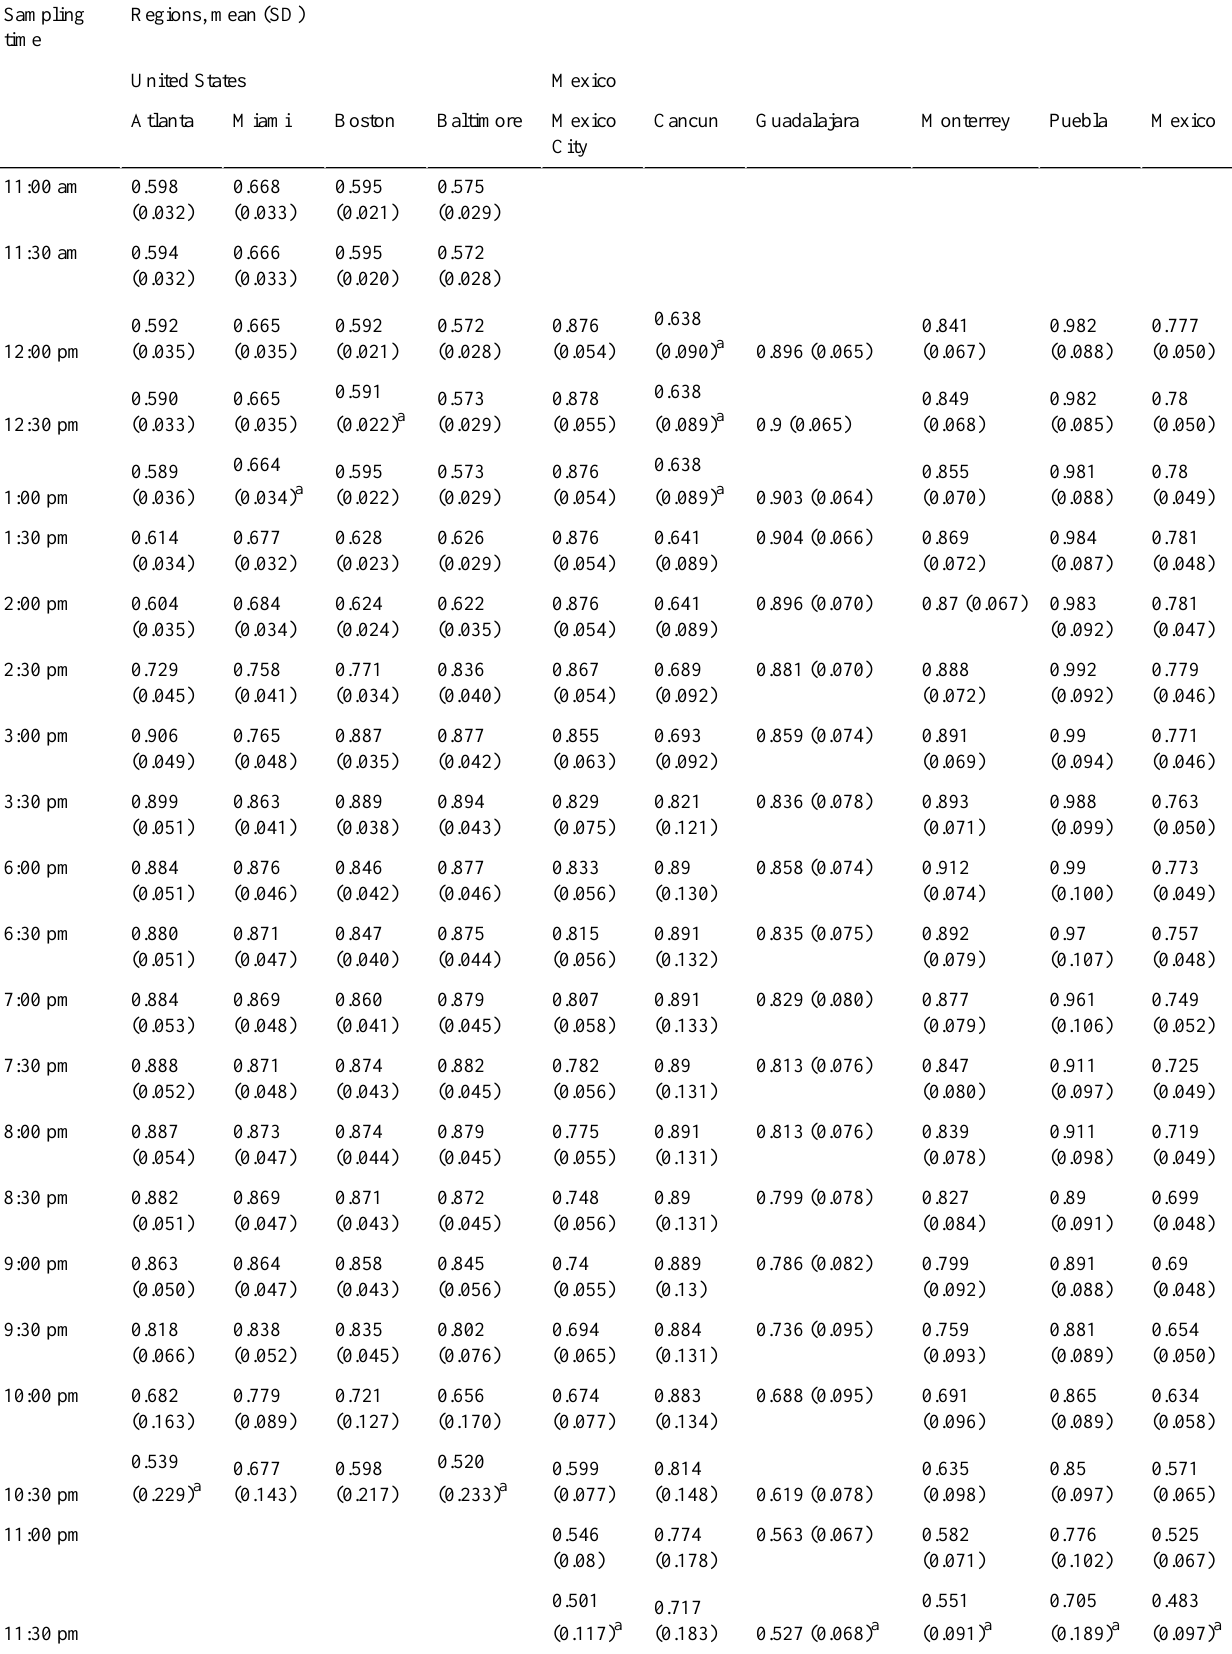
Table 1. Mean proportion of restaurants with available tables at lunch (11:00 am-3:30 pm) and dinner (6:00-11:30 pm) times for cities in the United States and